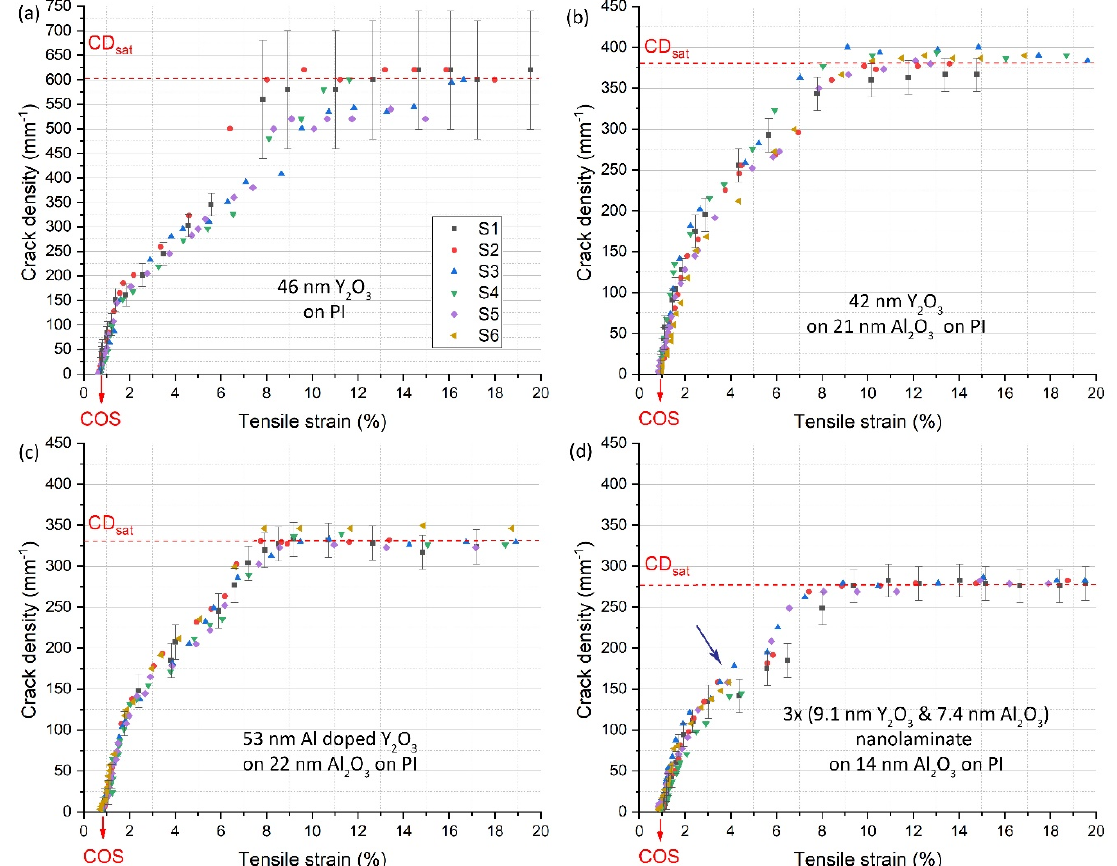
Figure 6. Crack density versus tensile strain plots for the Y 2 O 3 -based samples. ( a – d ) The specific film structure, the saturated crack density (CD sat ), and the crack onset strain (COS) are indicated. ( d ) The arrow indicates the formation of an additional distinct crack-density plateau. Uncertainties take account for sample variations, fitting residuals, and measurement accuracies. For clarity, the error bars are shown only for one sample per film material.